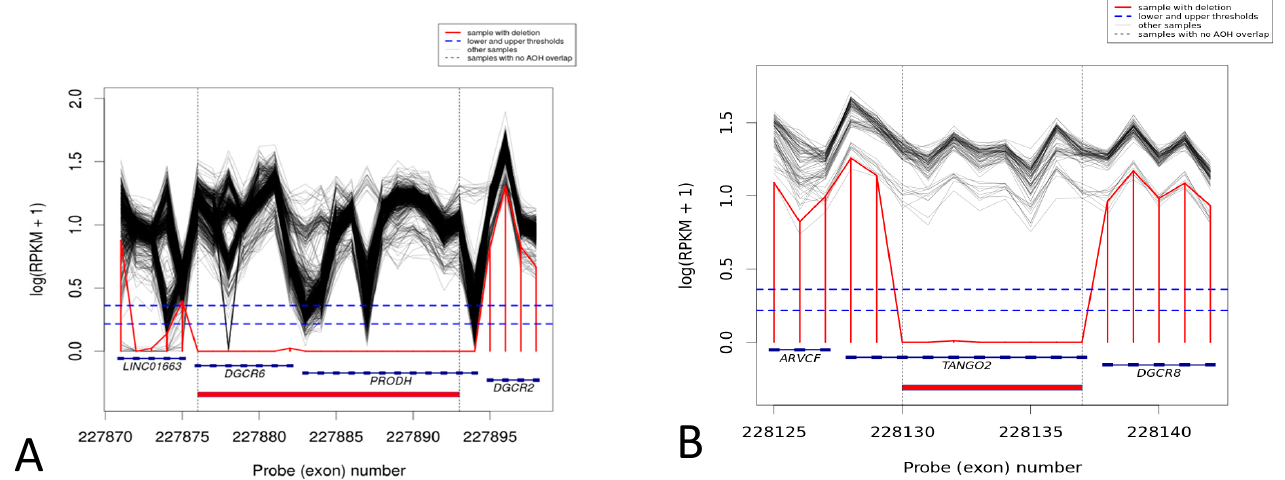
Figure 1. HMZDelFinder identified; ( A ) clinically uncertain, hemizygous deletion, in the remaining 22q11.2 region. The variant encompasses two genes: DGCR6 , PRODH (Chr22:18906447-18931248). ( B ) Pathogenic, hemizygous deletion, in the remaining 22q11.2 region. The variant encompasses 8 exons of TANGO2 (chr22:20043265-20064650).